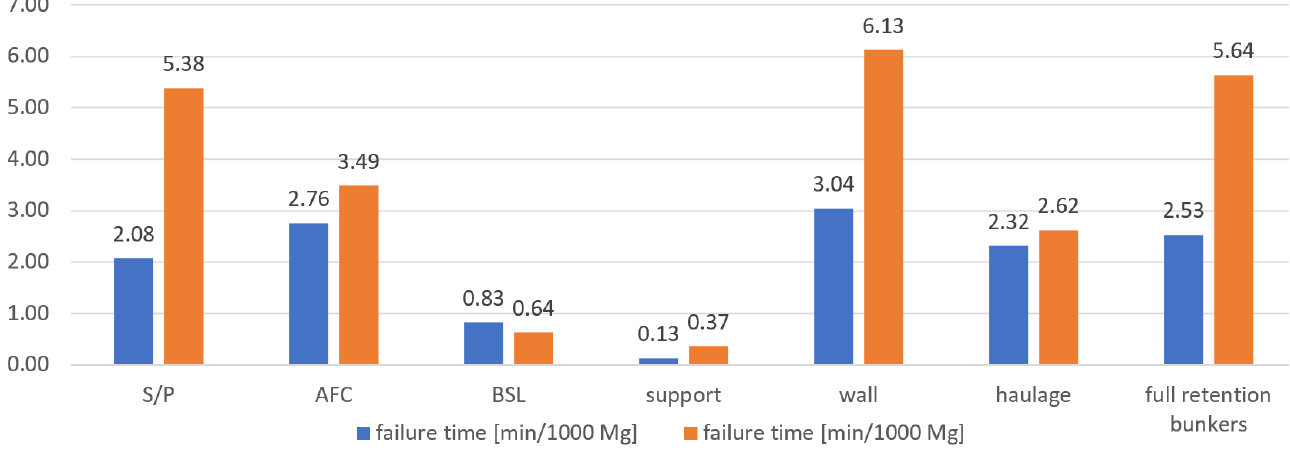
Figure 14. Comparison of the total number of failures per 1000 Mg of excavated material.